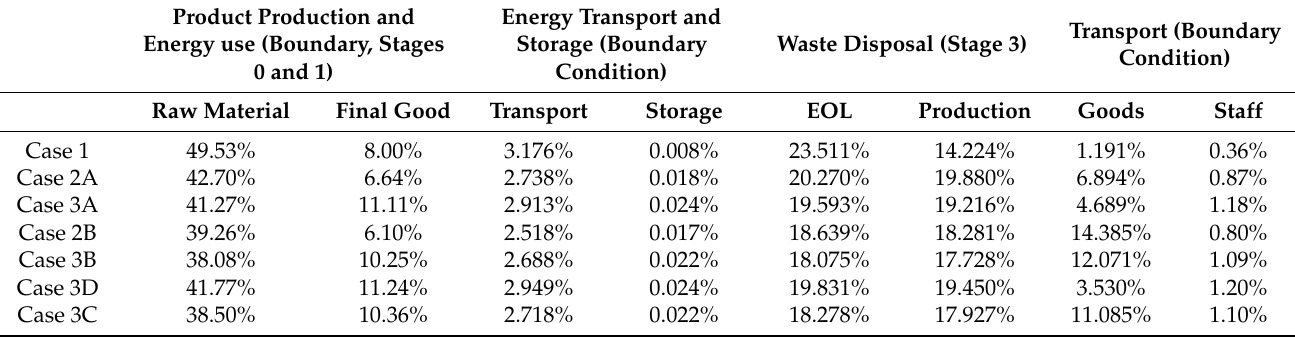
Table 38. Segregation and classification of the overall CF into the different industrial fields that compose every item in production.